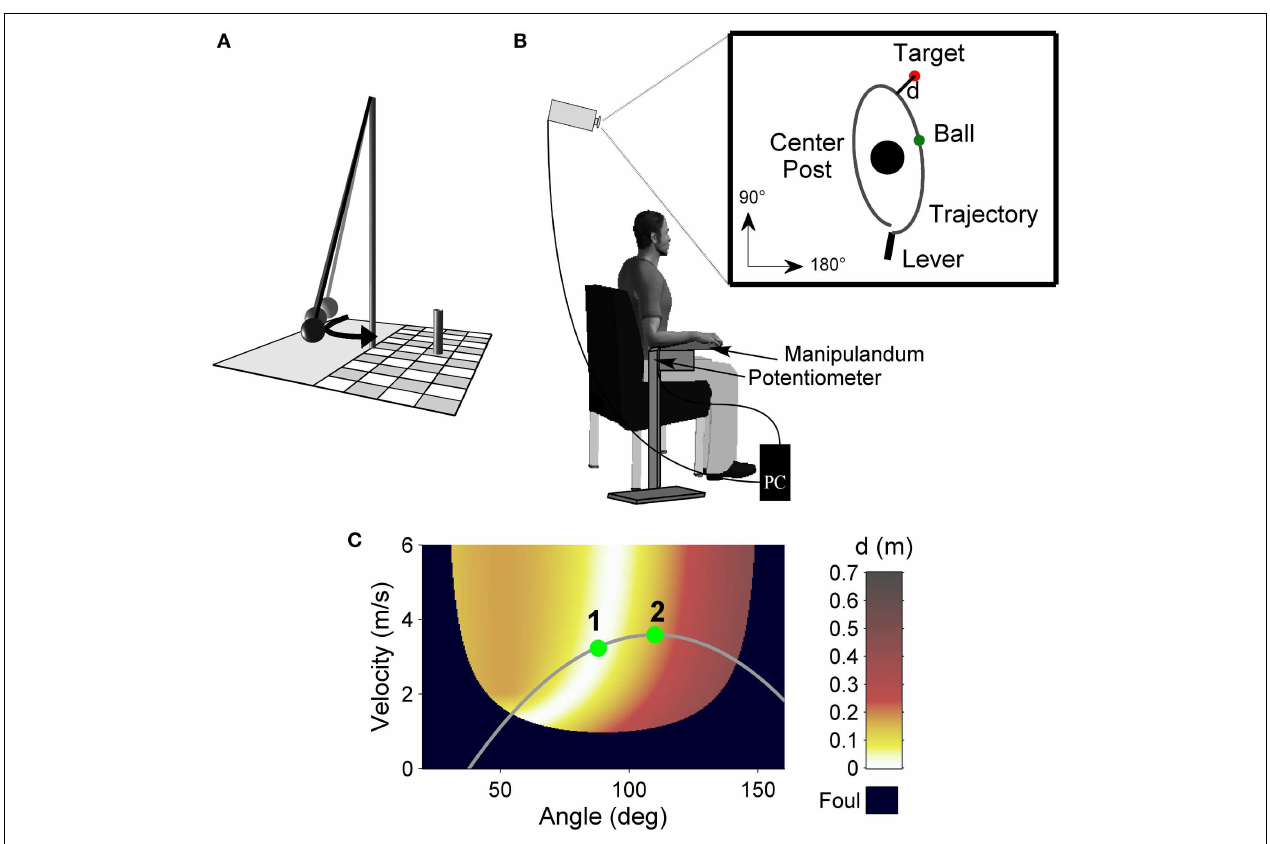
each combination of the execution variables (release angle and velocity) the color codes the result variable, the distance ( d ) of the resulting ball trajectory to the center of the target (error).White denotes the solution manifold with zero-error solutions.The gray curve represents a hypothetical throwing trajectory of the arm movement with two hypothetical release points and their respective timing. Release 2 occurs later on the throwing trajectory relative to release 1 and hence reaches lower